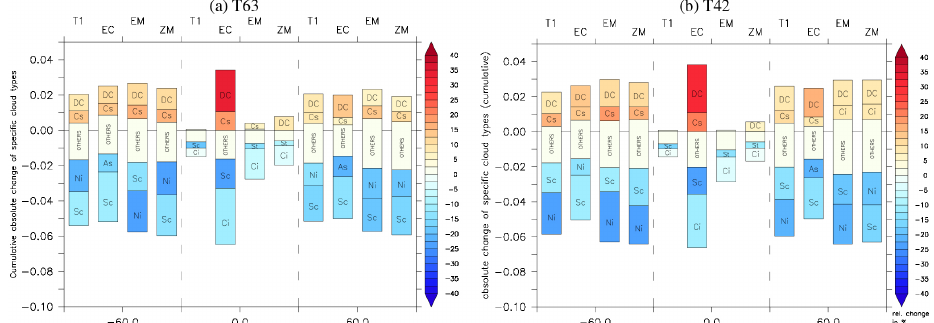
Figure 9. Change of different cloud types in the 2 × CO2 simulation. Each bar represents an average over 60 ◦ latitude (90 ◦ S to 30 ◦ S, etc.) for all simulations indicated in the top row of the graphs. The y axis denotes the absolute (cumulative) and the colour bar the relative change in %. The height of one particular bar identifies the absolute increase/reduction of the corresponding cloud type. Only the two highest positive and negative changes are labelled with the following abbreviations: DC=deep convective, Cs=cirrostratus, Sc=stratocumulus, Ni=nimbostratus, St=stratus, As=altostratus,